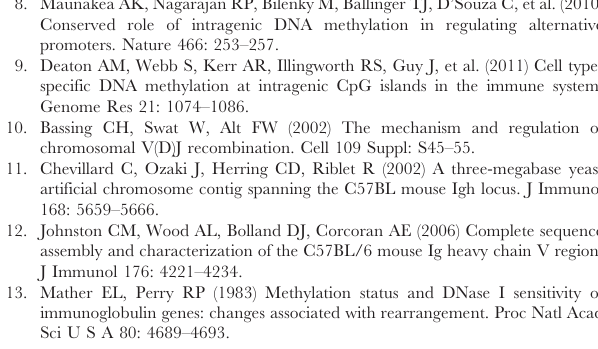
Figure S1 Comparison of DNA methylation status between two independent experiments. For each region analyzed in the paper, we used at least two independent DNA preparations starting with cells obtained from six mice for each sample. Methylation profiles of the regions amplified from two independent experiments were comparable, as shown with the example of the DFL16.1 region in RAG 2 / 2 pro-B mice. Figure S2 DNA methylation state of the mb-1 and b - globin locus activating region in different cell types. For our experiments we have chosen the previously characterized mb- 1 gene and its promoter as a positive and b -globin locus activating region as a negative control. Sequences from at least 12 individual colonies were analyzed for each cell type. Consistent with the observations of the Hagman group [29] mb-1 gene and its promoter are hypomethylated in early stages of B cell develop- ment. As expected mb-1 and its promoter were methylated in CD4 + CD8 + DP thymocytes and kidney cells, which served as a negative control for this region. b -globin locus activating region was methylated in a RAG2-deficient pro-B cell line, primary RAG2-deficient pro-B cells, and kidney. Figure S3 Relative positions of the CpG dinucleotides in the amplicons analyzed. Amplicons covering 11 regions of the germline IgH locus are depicted. Numbers in circles represent the order of the CpGs in each amplicon. D H gene segments are highlighted in green, J H 1 region is highlighted in orange. Recombination signal sequences (RSSs) with 12- and 23-bp